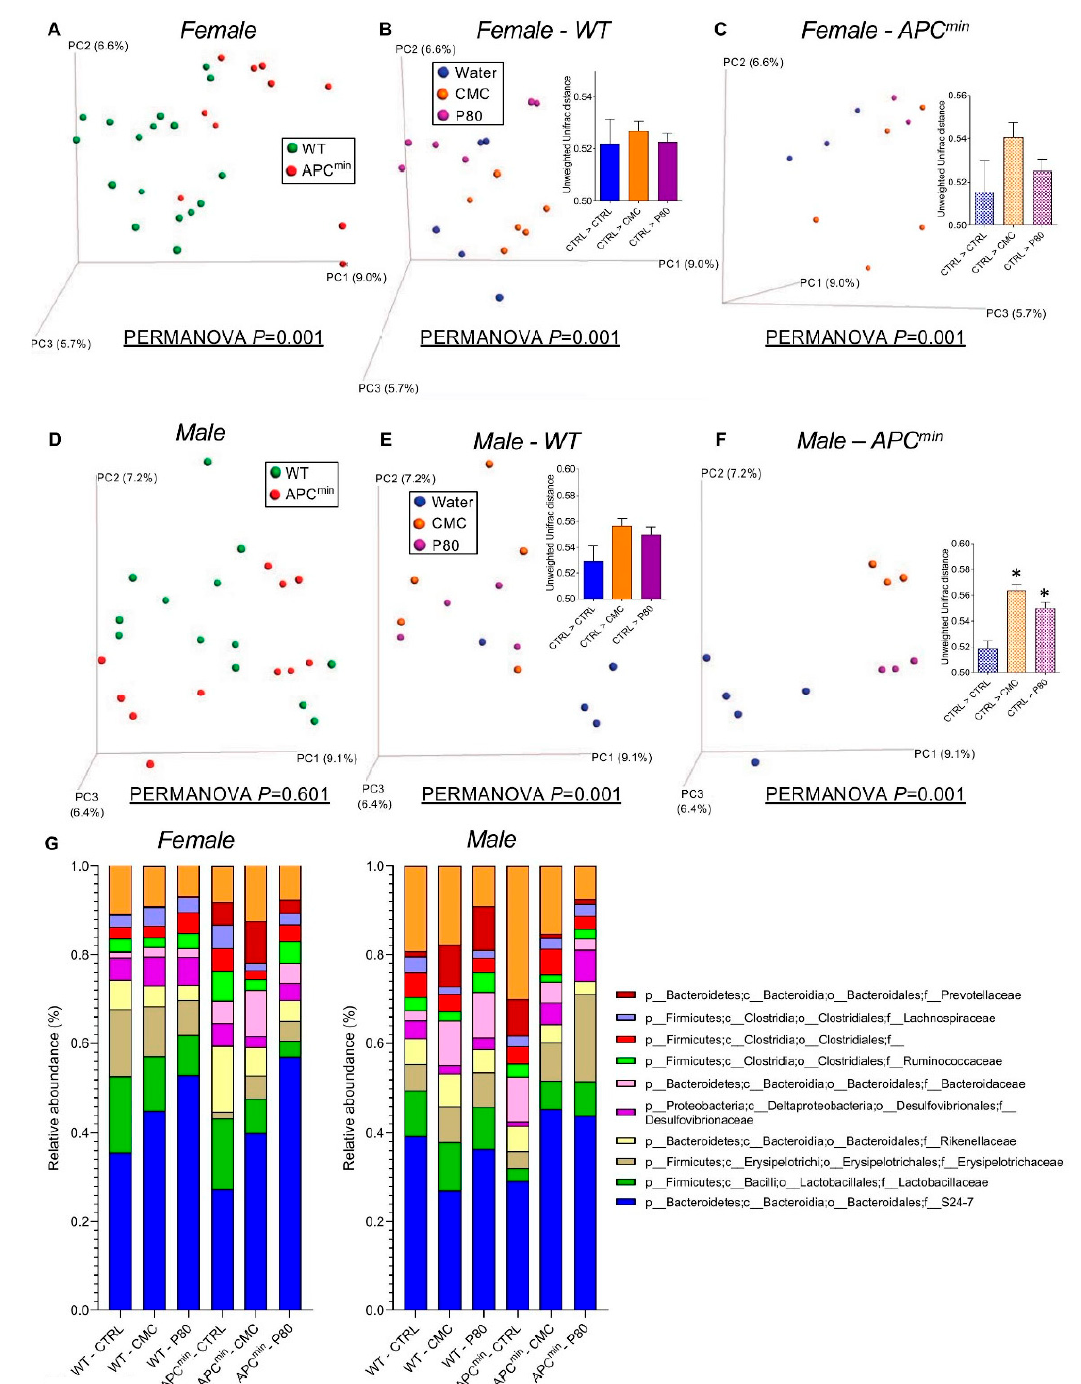
Figure 6. Dietary emulsifiers alter intestinal microbiota composition in WT and APC min mice. Seven-week-old WT and APC min mice were exposed to drinking water containing CMC or P80 (1.0%) for 15 weeks. Fecal microbiota composition was analyzed using Illumina sequencing of the V4 region of 16S rRNA genes. ( A – F ) Principal coordinate analysis of the unweighted UniFrac distance matrix of female ( A – C ) and male ( D – F ) mice. Histograms within the principal coordinates analysis (PCoA) plots represent the unweighted UniFrac distance separating water-treated animals from other groups (water, CMC, and P80). For cluster analysis on principal coordinate plots, categories were compared, and the statistical significance of clustering was determined using the Permanova method. ( G ) Taxonomic representation of the microbiota at the family level. For female mice, n = 5 for the WT–CTRL group, 3 for the APC min –CTRL group, 6 for the WT–CMC group, 5 for the APC min –CMC group, 6 for the WT–P80 group and 2 for the APC min –P80 group. For male mice, n = 4 for the WT–CTRL group, 5 for the APC min –CTRL group, 5 for the WT–CMC group, 3 for the APC min –CMC group, 4 for the WT–P80 group and 3 for the APC min –P80 group (* indicates statistical